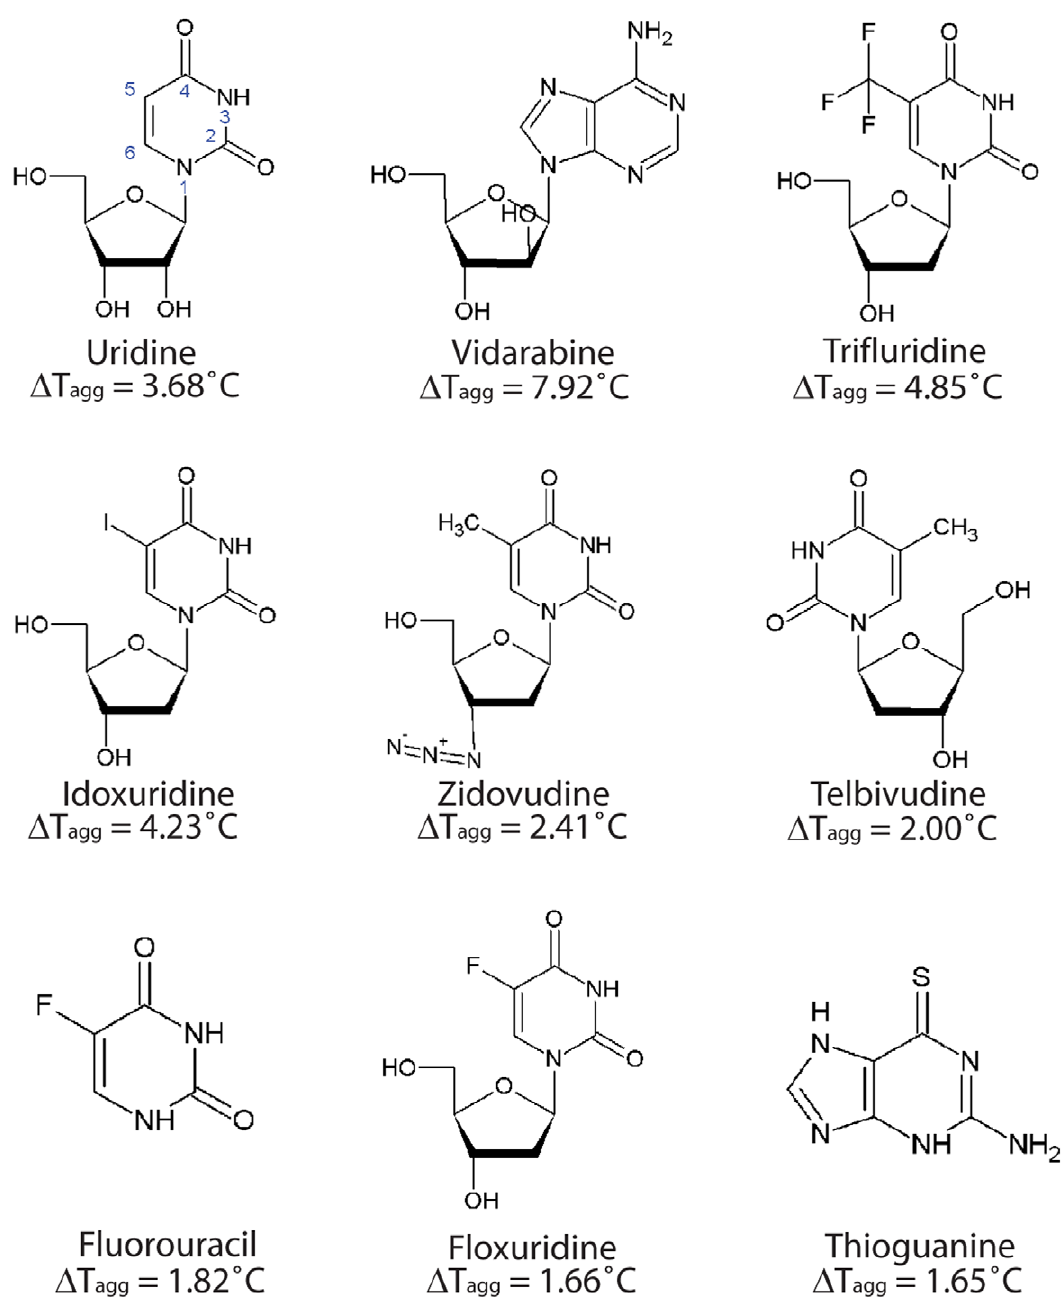
Figure 3. Ligands of UPP1 and mean D T agg with 1000 m M NA. doi:10.1371/journal.pone.0037724.g003 Ribonucleotide Reductase Large Subunit (RRM1)